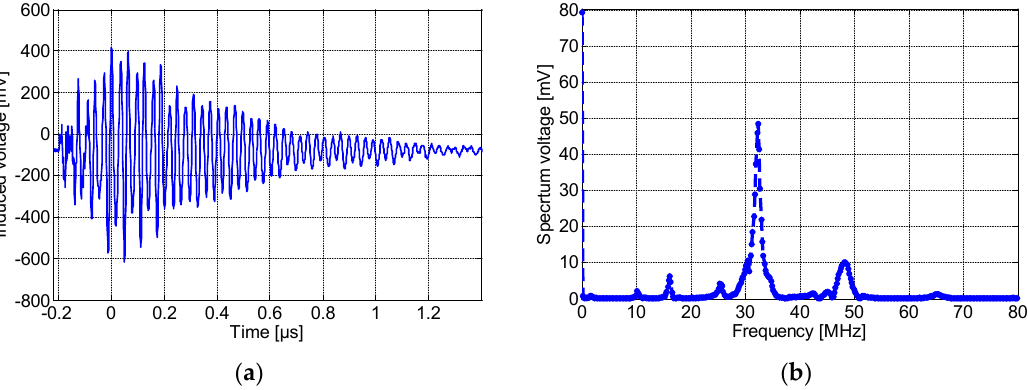
Figure 10. ( a ) The time-domain wave due to partial discharge at 8.2 kV and ( b ) its frequency spectrum, detected by the non-spiral inductive sensor placed on P1.